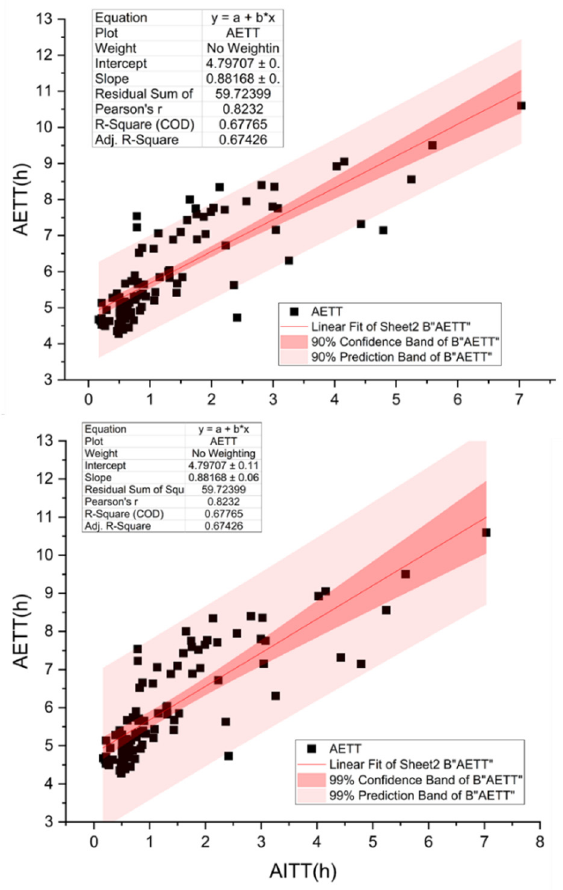
Figure A3. Scatter chart with fitting confidence interval.